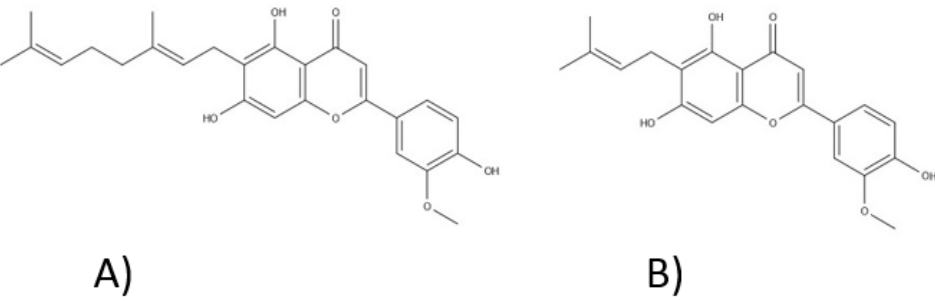
Figure 8. The structures of cannflavins: ( A )—cannflavin A and ( B )—Cannflavin B. Cannabis sp. flavonoids have antibacterial, anti-inflammatory, antiproliferative, and neuroprotective properties. Flavonoids can affect the pharmacokinetics of Δ 9 -tetrahydrocannabinol [80]. Besides, apigenin has estrogen and anxiolytic properties. Cannflavins A and B, due to the inhibition of 5-lipoxygenase and prostaglandin E 2 , show anti-inflammatory effects [42]. Moreover, cannflavin B exhibits antimicrobial and antileishmanial activity [80].